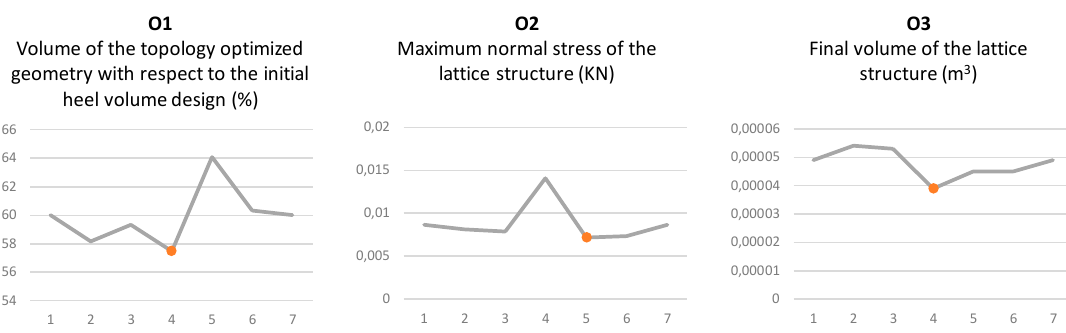
Table 3. Multi-objective optimization solutions with its variable values and achieved objectives. V1—Heel advance in the waist path (range from 0 to 1), V2—Offset value for the boundary of the heel support surface (mm), V3—lattice infill unit cell size (mm), V4—scale factor for the length of the